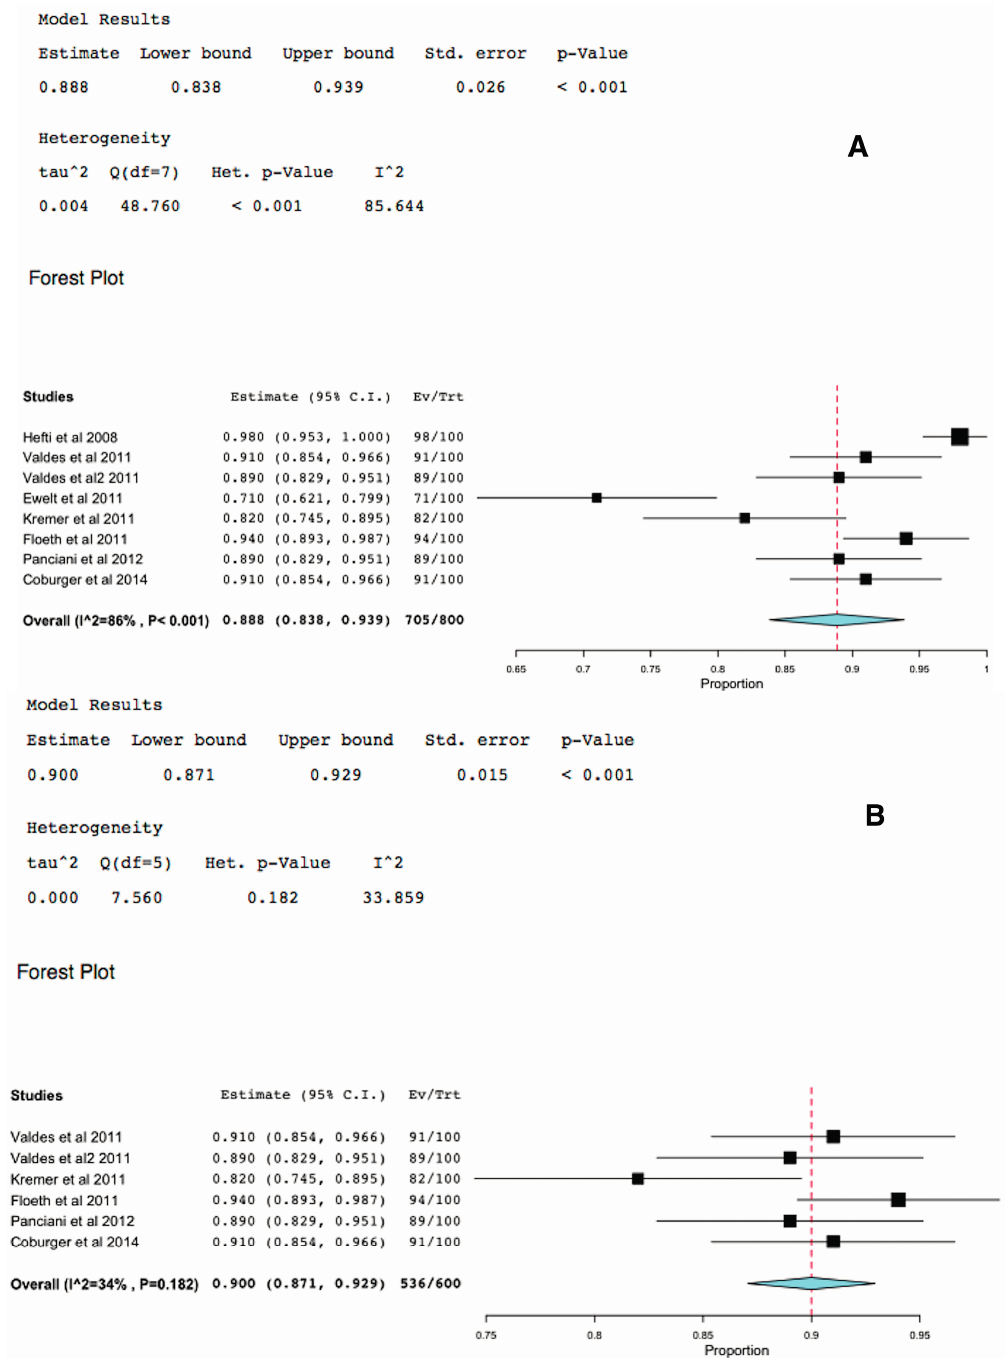
Figure 5. Forest plot (meta-analysis) and heterogeneity of 5-ALA-FIGR specificity. ( A ) excludes studies with non-GBM data and ( B ) includes them, because studies included other types of tumors other than GBM. (Squares represent the mean, the bigger the square is the more weight given because of the narrower 95% CI, the diamond represent the mean in the combined data in the meta -